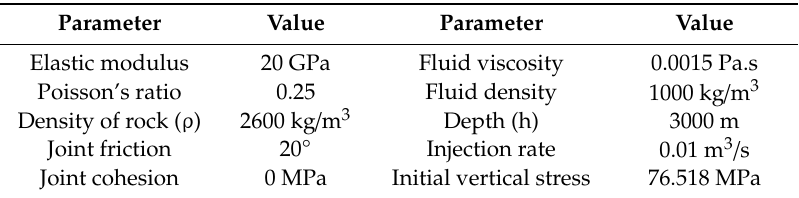
Figure 3. Three-dimensional model of rock with two horizontal joints and one vertical joint: ( a ) the model of joint; ( b ) the model with blocks and joints. Table 1. Values of parameters for simulation